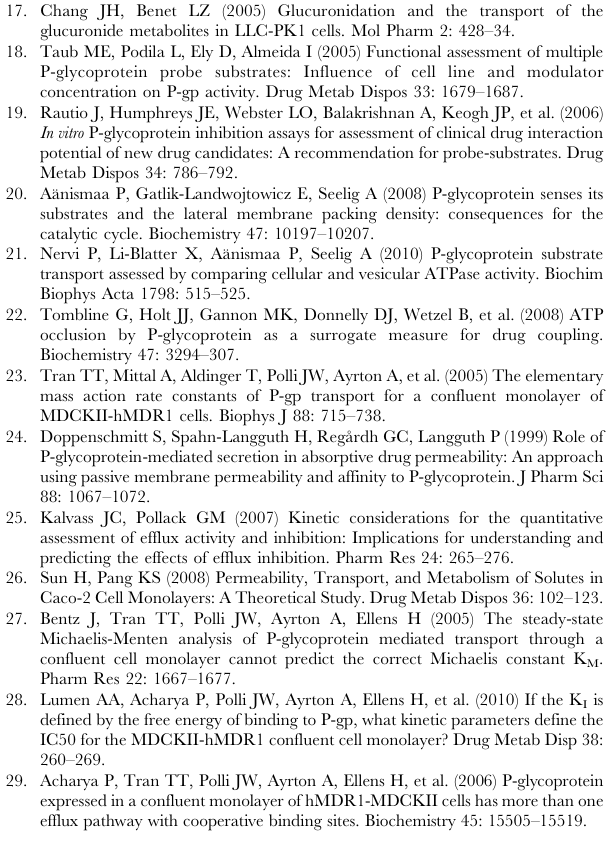
Table S1 Effect of adding bidirectional transporters on